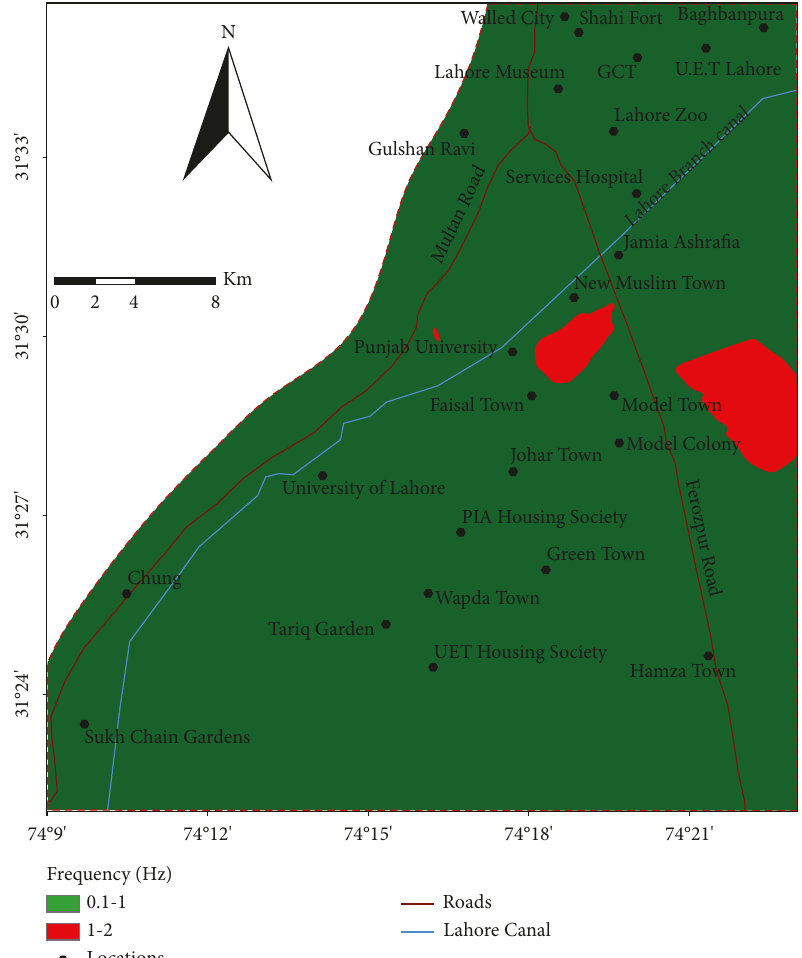
Figure 9: Map characterizing the study area into high (red color) and low (green color) reigns of predominant